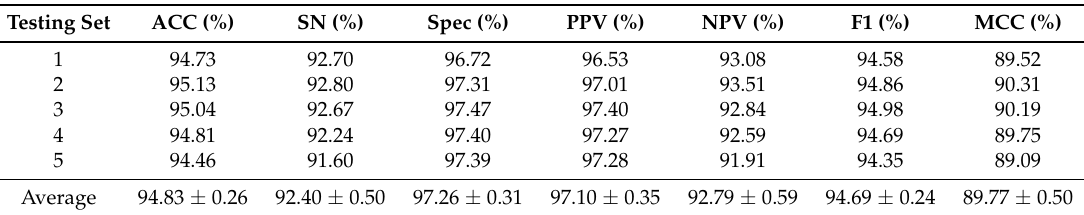
Five-fold cross validation result obtained by using our proposed method on the S . cerevisiae dataset.